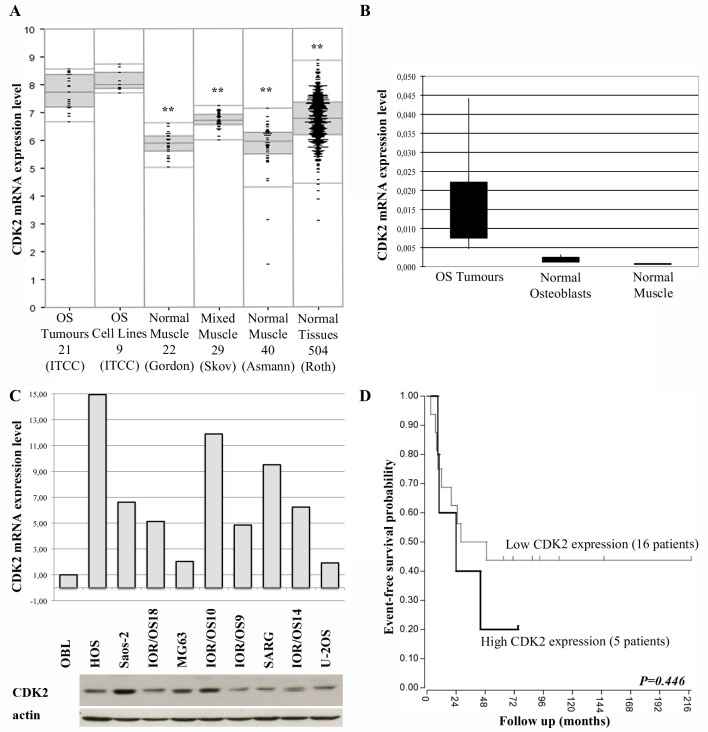
CDK2 gene expression analyses in human osteosarcoma.A) CDK2 expression in high-grade osteosarcoma tumour samples and cell lines in comparison with normal tissues. Numbers indicate the samples analysed in each group. Asterisks (**) indicate statistically significant differences with the osteosarcoma tumour samples (P<0.01 by ANOVA test). The bottom and top of each box are, respectively, the first and third quartiles of gene expression level values. The band inside each box is the median (second quartile) of gene expression level values, whereas outliers (values below the first or above the third quartile) are plotted outside the box. The "OS Tumors 21 (ITCC)" data set was a series of 21 primary, high-grade osteosarcomas of the extremities, non-metastatic at diagnosis, arisen in patients younger than 40 years collected at the Orthopaedic Rizzoli Institute (IOR, Bologna, Italy) (GEO ID: GSE87437). The "OS Cell Lines 9 (ITCC)" data set included nine IOR human osteosarcoma cell lines. Both data sets were shared within the Innovative Therapies for Children with Cancer European Consortium (ITCC; http://www.itcc-consortium.org/). The GEO ID of the other data sets are: Normal Muscle 22 (Gordon) (GEO ID: GSE38718), Mixed Muscle (skeletal) 29 (Skov) (GEO ID: GSE6798), Mixed (skeletal) Muscle 40 (Asmann) (GEO ID: GSE9103), Normal Tissues 504 (Roth) (GEO ID: GSE7307). B) CDK2 expression level in high-grade osteosarcoma tumour samples in comparison with normal human normal osteoblasts and normal muscles assessed by qRT-PCR. C) Relative CDK2 gene expression level in the nine human osteosarcoma cell lines of the "OS Cell Lines 9 (ITCC)" data set, assessed by qRT-PCR and western blot. D) Event-free survival probability of the 21 high-grade osteosarcoma patients (GEO ID: GSE87437) stratified according to the CDK2 gene expression levels. The group of high expressors included patients with CDK2 expression levels at diagnosis equal or higher to the 75 percentile of the whole group. Curves were drawn by using the Kaplan-Meyer method and significance was calculated with the log-rank test.